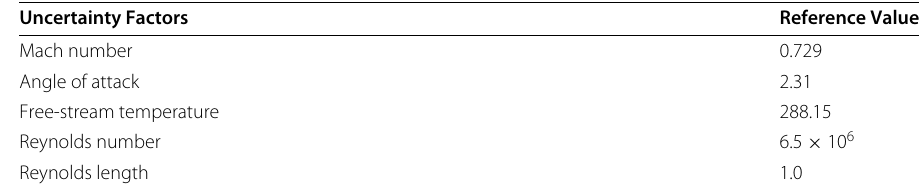
Table 2 Reference value of uncertainty factors in experiments